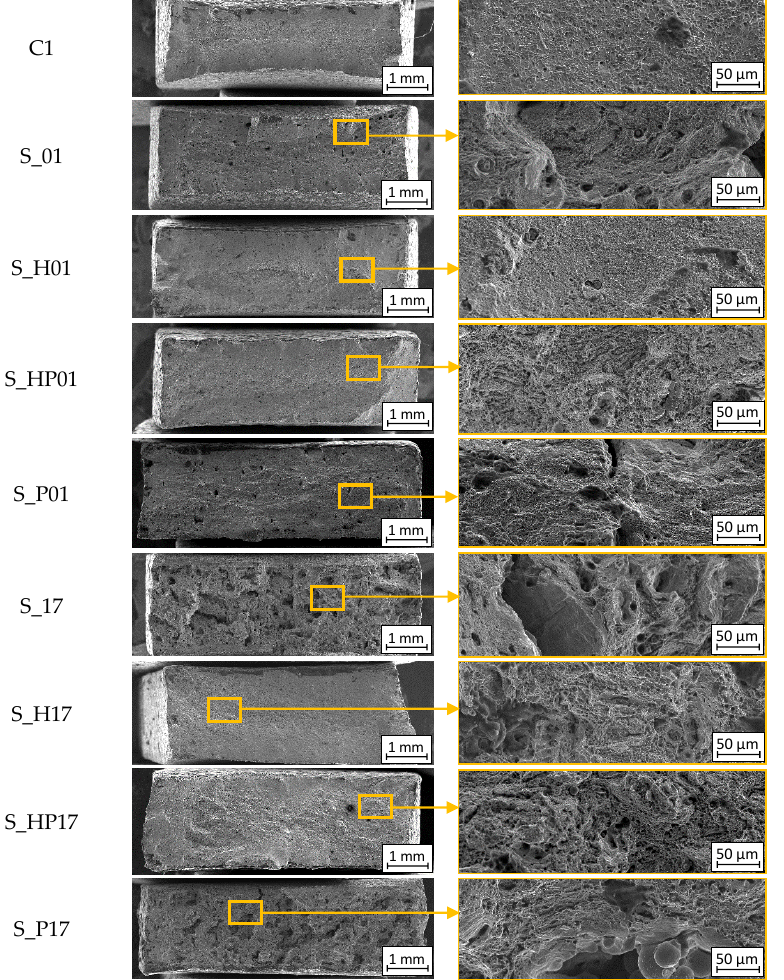
strength, and ( c ) elongation at break.